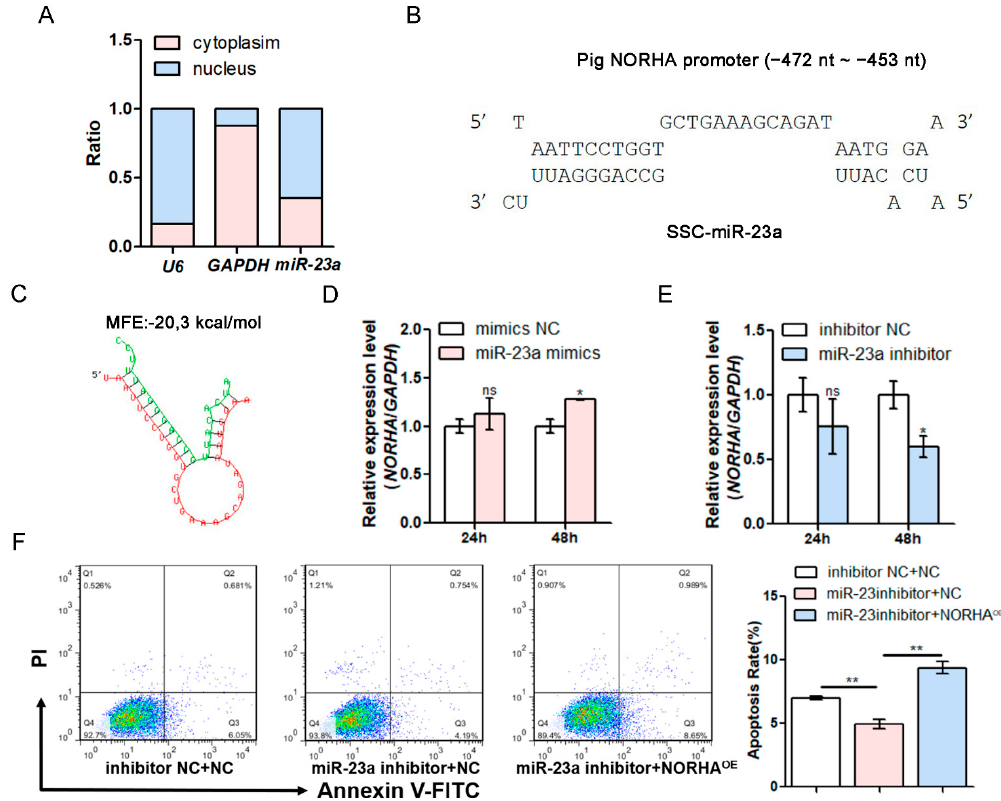
Figure 2. miR-23a induces pGC apoptosis by activating NORHA expression. ( A ) Subcellular localiza- tion analysis of miR-23a by nucleocytoplasmic separation. U6 is a reference for the nucleus (blue) and GAPDH is a reference for the cytoplasm (red). ( B , C ) Potential binding of miR-23a to the lncRNA NORHA promoter. ( B ) An MRE of miR-23a was located in the NORHA promoter. ( C ) The minimum free energy (MFE) was predicted by RNAhybrid. ( D , E ) After transfection with miR-23a mimics ( D ) or the miR-23a inhibitor ( E ), NORHA levels were examined by qRT-PCR at 24 h and 48 h in pGCs. ( F ) After co-transfection with the miR-23a inhibitor and pcDNA3.1- NORHA , the pGC apoptosis rate was examined by FACS at 48 h. Data are expressed as the mean ± S.E.M., and significance was tested using a t -test ( D , E ) and a one-way ANOVA (F) (ns, not significant, * p < 0.05, ** p < 0.01). 3.3. miR-23a Is a saRNA of lncRNA NORHA To test the miR-23a activation of lncRNA NORHA transcription via miR-23a MRE in its promoter, two reporter vectors of the porcine NORHA promoter were generated (Fig- ure 3A). The luciferase reporter assays showed that the luciferase activities of the NORHA promoter were significantly increased upon the overexpression of miR-23a in pGCs, while no significant changes were observed in the luciferase activities of the promoter with a mutation-type MRE motif of miR-23a (Figure 3B,C), indicating that miR-23a enhances the promoter activity of NORHA via an MRE motif of miR-23a in its promoter. The activation of target transcription by saRNAs has been shown to depend on AGO2 [23]. We therefore performed a ChIP assay by a specific anti-AGO2 antibody to assess whether miR-23a guides AGO2 to bind to the NORHA promoter in pGCs. Compared with the X site (with- out the MRE motif of miR-23a) within the intron 1 of NORHA , a significant enrichment of AGO2 binding was observed in the MRE motif of miR-23a in the region of the NORHA promoter (Figure 3D), indicating that AGO2 binding was guided by miR-23a. In addition, RNAa has also been shown to be involved in the histone modification at the target pro- moter region [22,24]. As expected, the overexpression of miR-23a resulted in the decreased enrichment of H3K9me2 and H3K9me3 at the MRE motif for miR-23a in the region of the NORHA promoter (Figure 3E). Overall, these data suggest that miR-23a is a saRNA of lncRNA NORHA in pGCs.